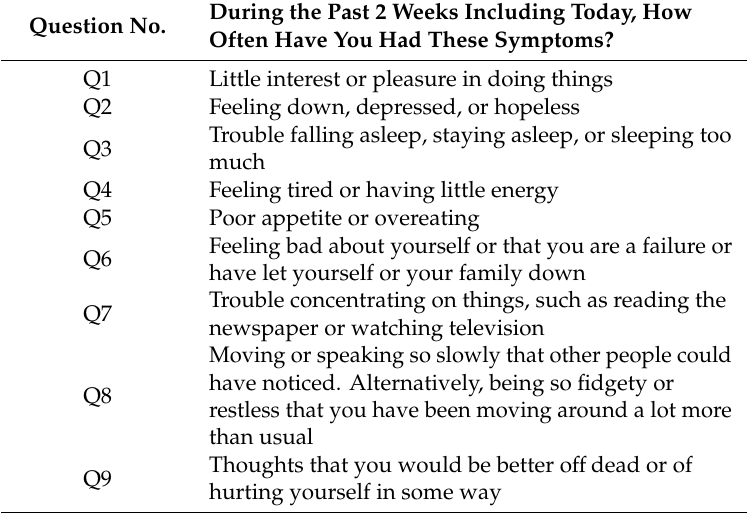
Table 1. Patient Health Questionnaire-9 depression assessment questions.